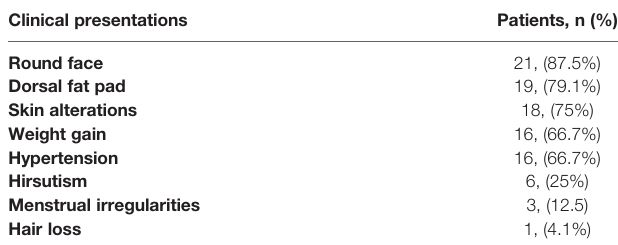
TABLE 2 | Clinical presentations of patients.